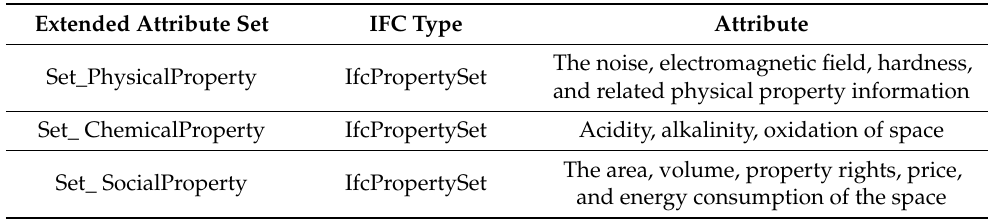
Table 4. Definition of the attribute set of indoor space.